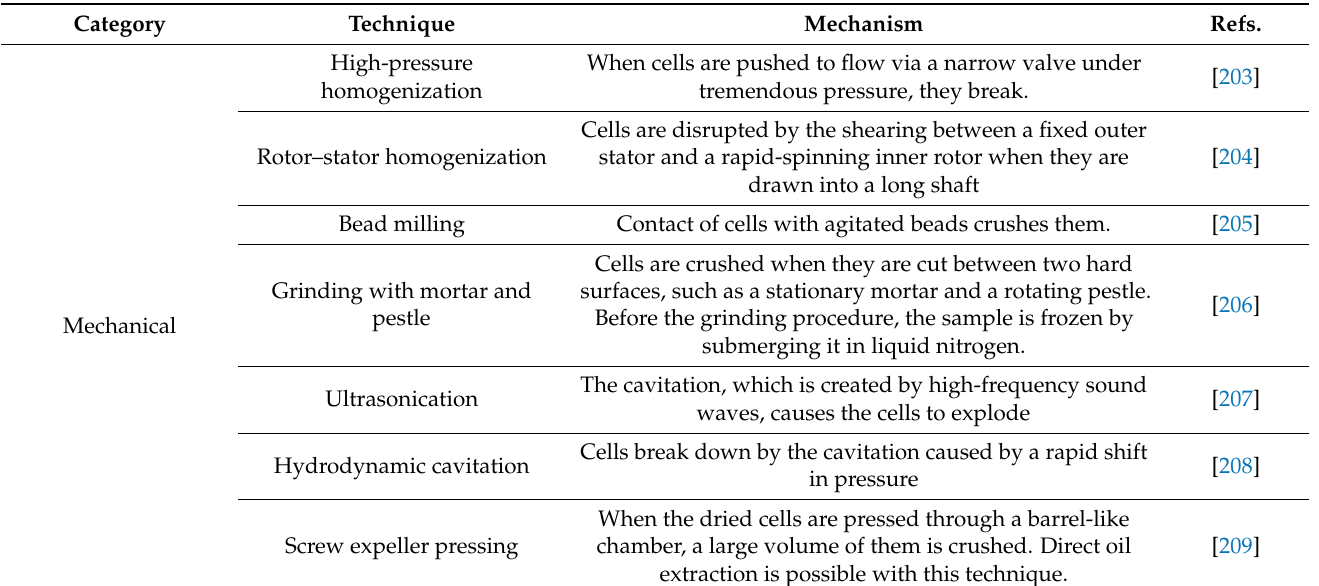
Table 10. Techniques for microalgae cell extract and cell rupture